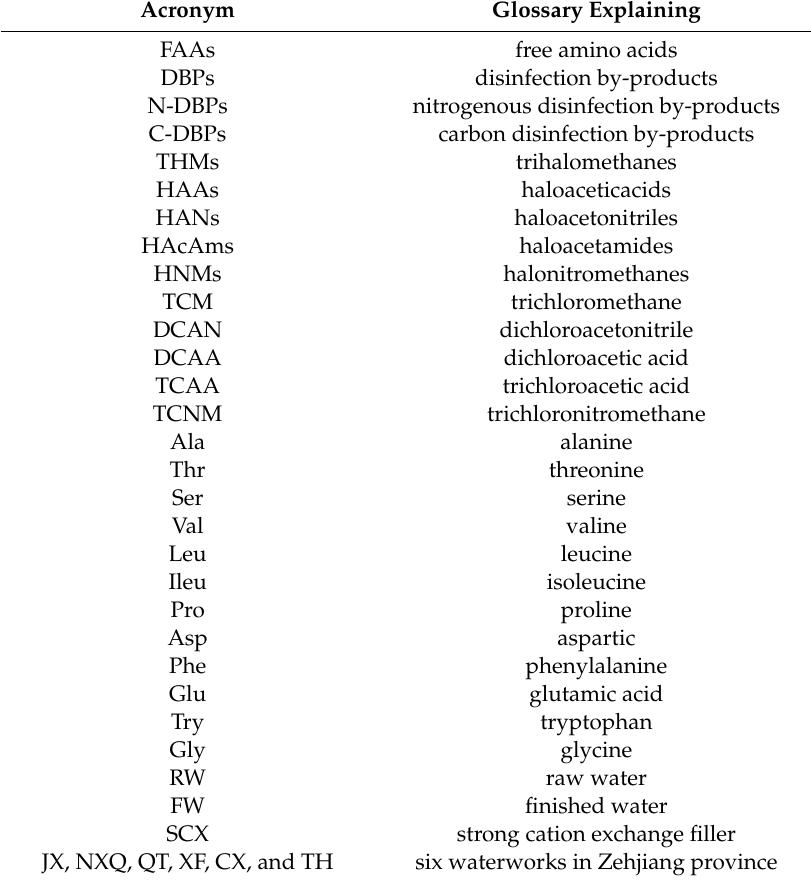
Table 2. Glossary explaining of